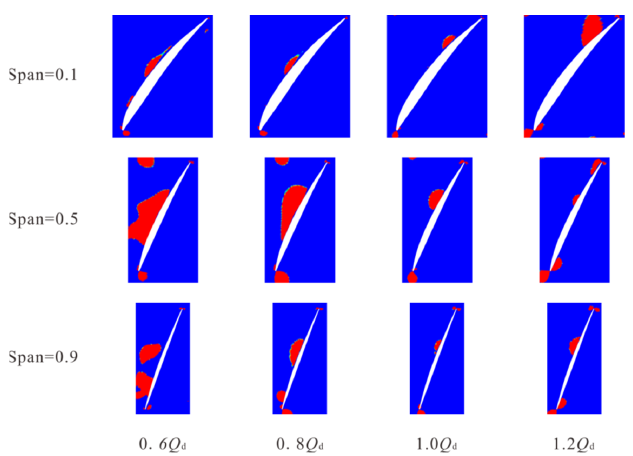
Figure 10. The distribution of pressure gradient exceeding threshold in impeller at different flow rates. (The red area is above the pressure gradient threshold and The blue area is below the pressure gradient threshold.).